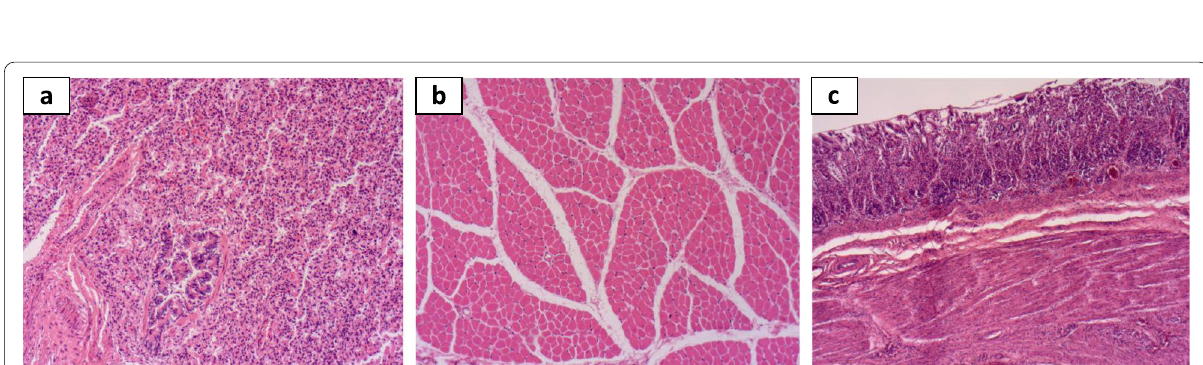
Fig. 3 Histology findings of different organs, hematoxylin and eosin (HE) coloration. a Alveolar collapse with polymorphic inflammatory infiltrate and vascular congestion